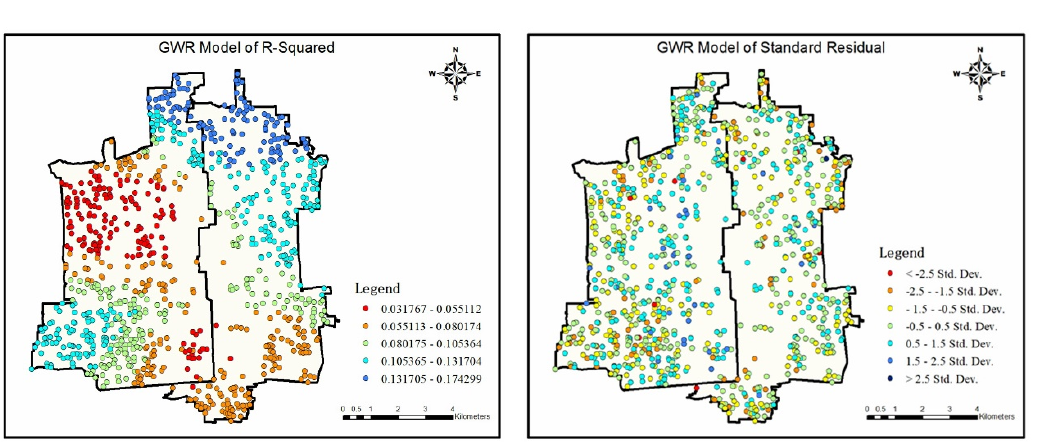
Table 6. Comparison of GWR models.